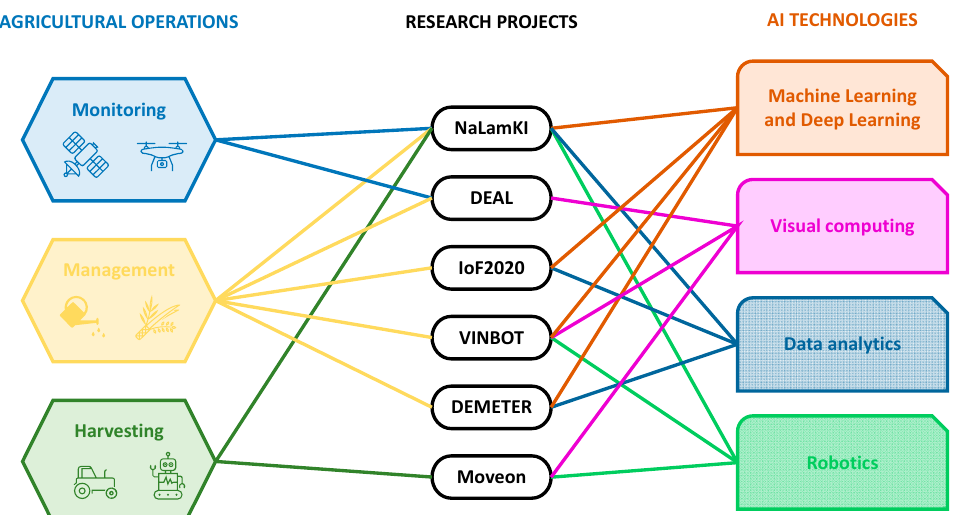
Figure 1. Conceptualization of the several agricultural operations and AI related technologies of the European research projects described in the paper.